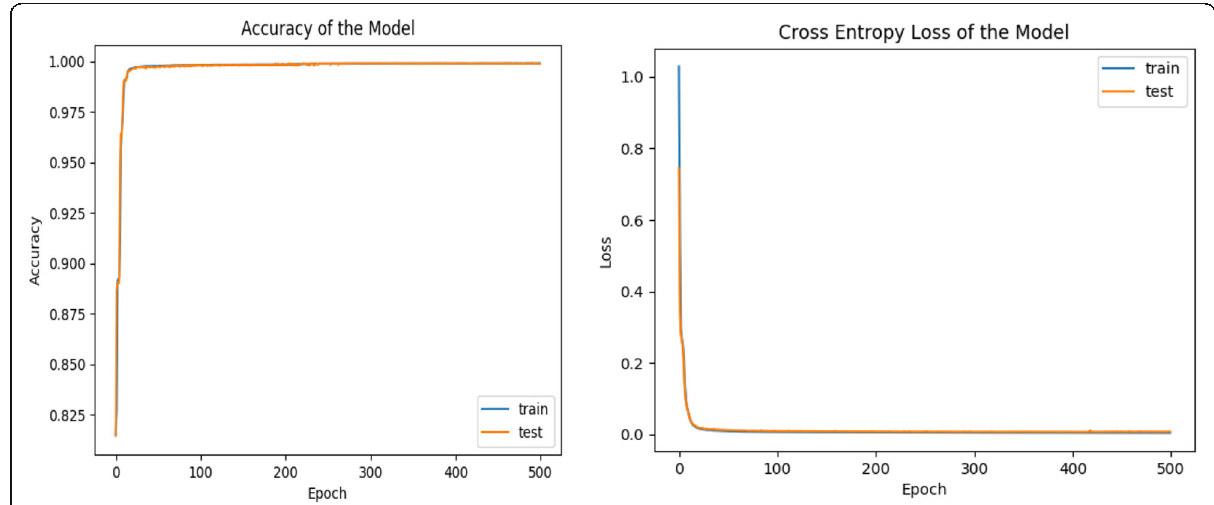
Fig. 4 Accuracy and Cross Entropy Loss of the Model for CICIDS2017 Dataset